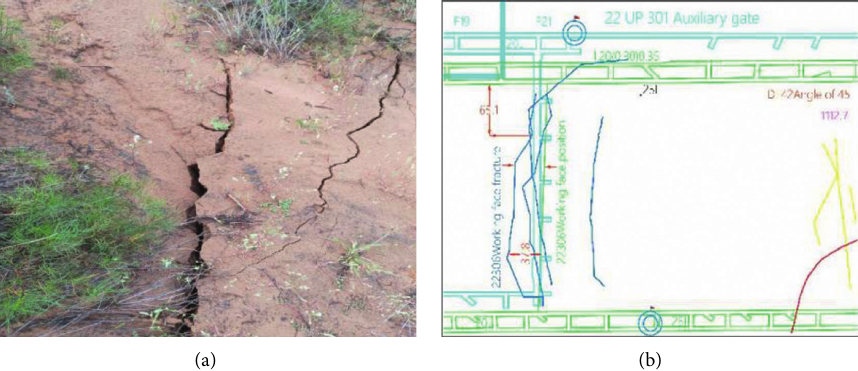
Figure 5: Distribution of surface subsidence cracks in the 22306 working face of the Shigetai mine.